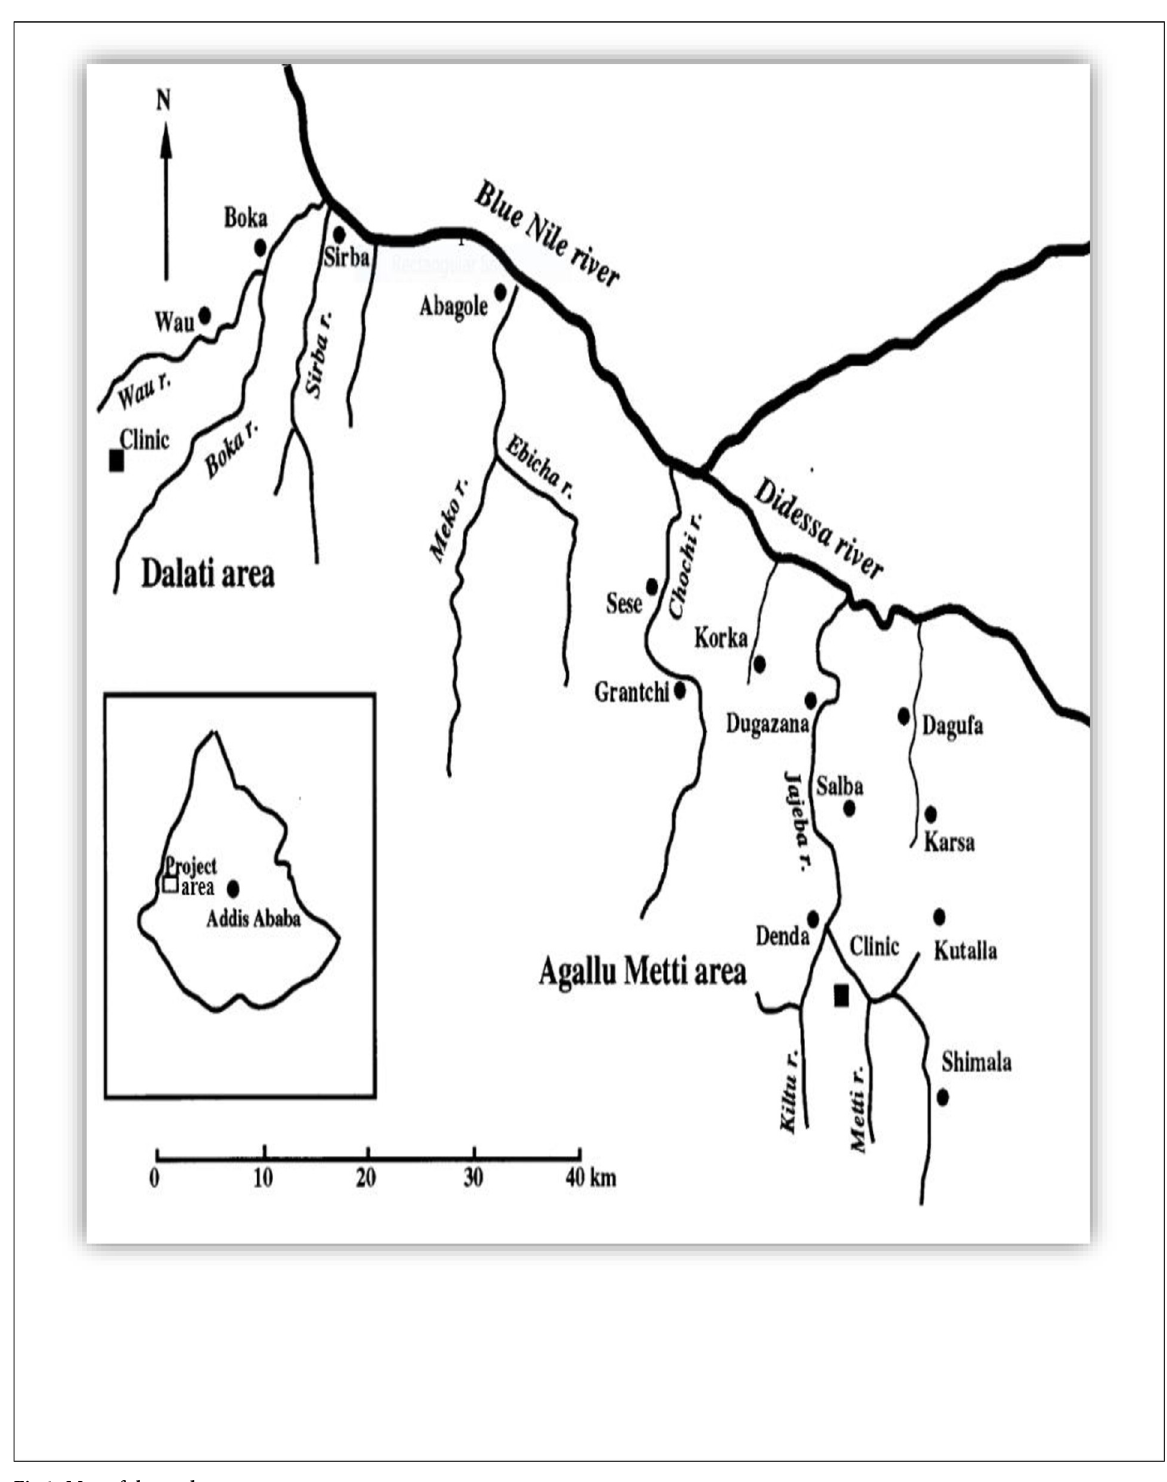
Fig 1. Map of the study areas.